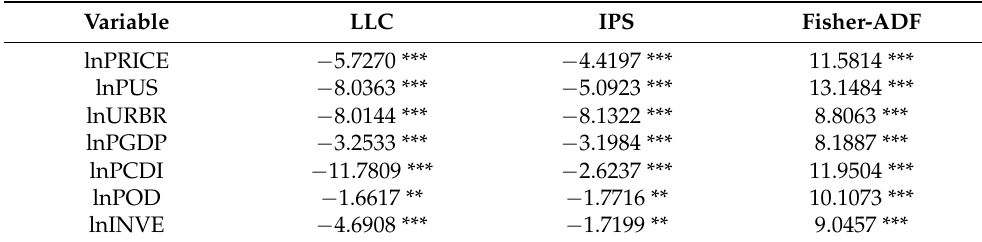
Table 2. Panel unit root test results of the